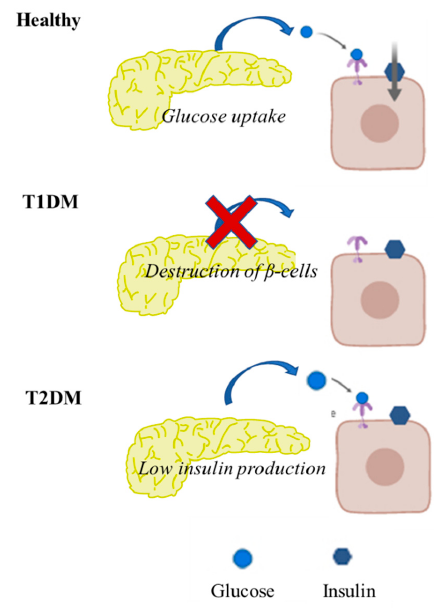
Figure 1. Main characteristics of pancreatic function in healthy individuals versus in diabetic individuals. In heathy individuals, the pancreas responds to hyperglycaemia with insulin secretion aiming to maintain gluco-homeostasis. Diabetes occurs when the pancreas fails to produce insulin, DMT1, insulin-dependent, or when insulin produced is insufficient or unable to produce gluco- homeostasis (DMT1).